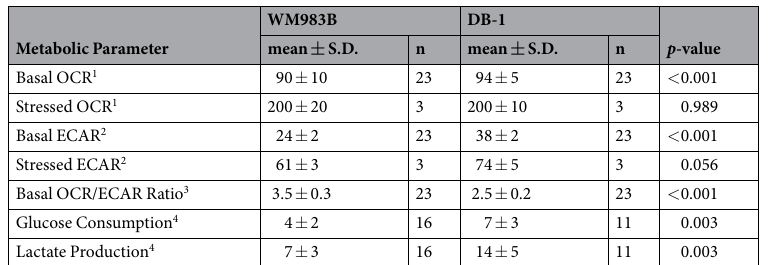
Table 1. WM983B cells are less glycolytic than DB-1 cells. We display metabolic parameters derived from in vitro Seahorse and YSI metabolic assays, including oxygen consumption rate (OCR) and extracellular acidification rate (ECAR). Data shown as mean ± S.D. 1 pmol/2 × 10 4 cells/min; 2 mpH/2 × 10 4 cells/min; 3 pmol O 2 /mpH; 4 nmol/10 6